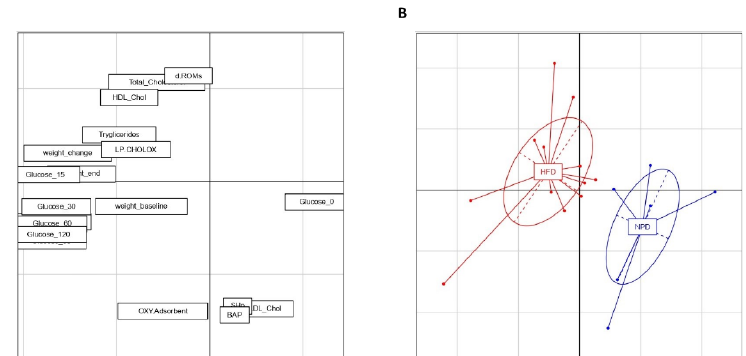
Figure 8. Principal component analysis (PCA) of measured variables in the HFD and NPD groups. PCA with PC1 (35.58%) on the x-axis and PC2 (16.75%) on the y-axis. ( A ) The loading of the 2 prin-